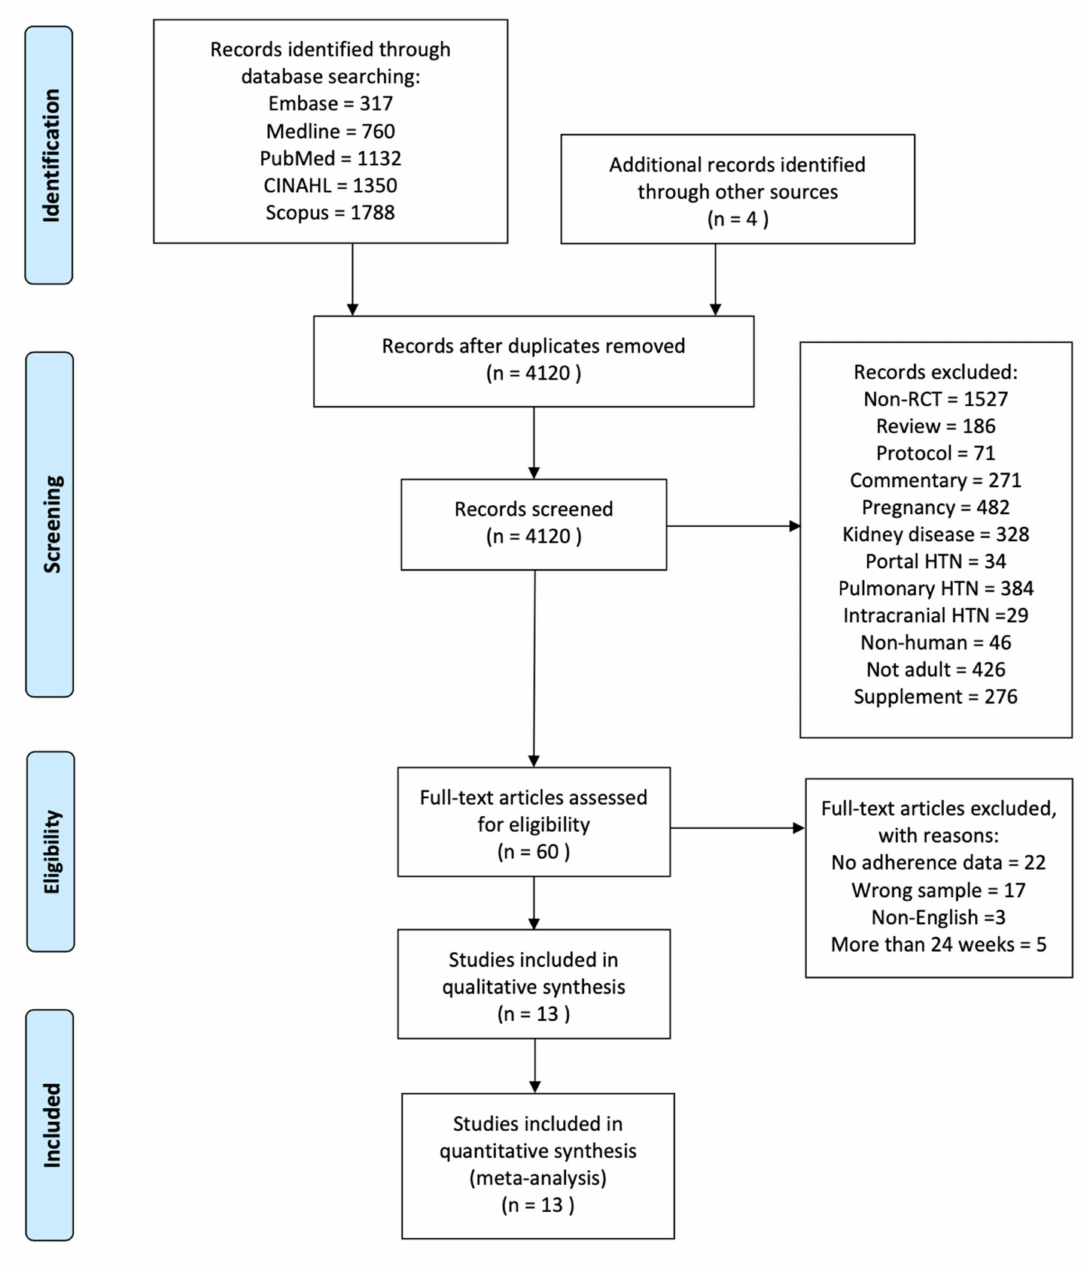
Figure 1. Flow diagram of literature selection process. (RCT = randomized control trial; HTN =